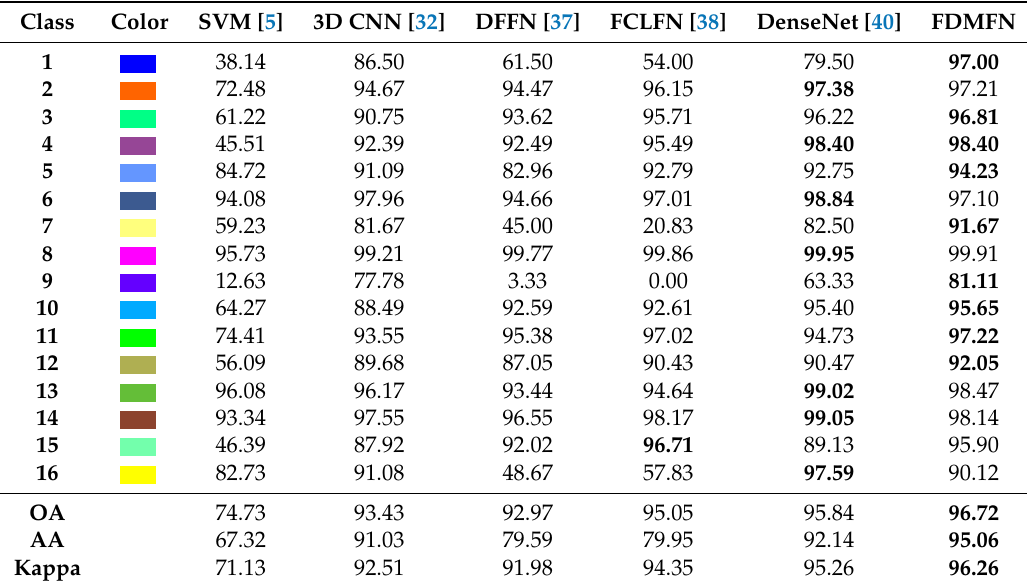
Figure 7. Classification maps and overall classification accuracies for the IP dataset. DFFN, deep feature fusion network; FCLFN, fully convolutional layer fusion network. Table 6. Classification accuracies (in %) of different methods for the IP dataset using 5% of labeled samples for training. The best results are highlighted in bold